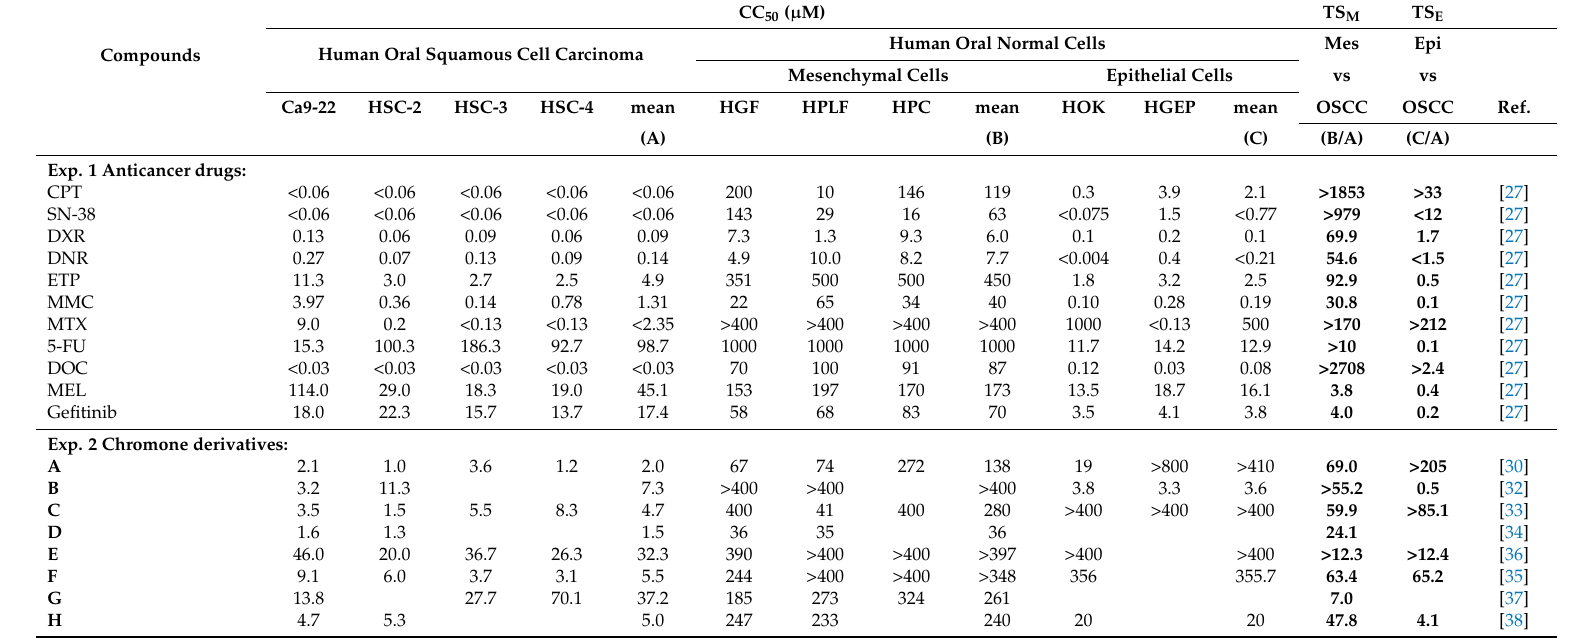
Table 1. Comparison of keratinocyte toxicity between popular anticancer drugs (Exp. 1) and chromone derivatives (Exp.